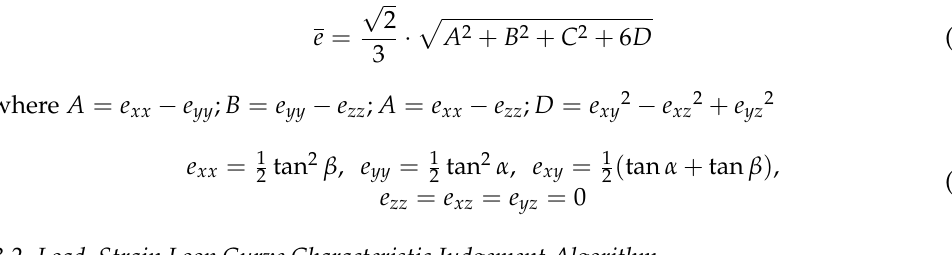
Figure 11. Load–strain distribution at different distances from the crack tip of Q&P 980 steel: ( a ) Measure points layout; ( b ) load–strain curve near the crack tip; ( c ) abstracted load–strain curve. The load–strain curve characteristic judgment algorithm was used to judge the de- formation region type according to the different characteristics of the load–strain curves of the pixel points in the crack tip region. There were 26 speckle images in each group of cyclic loads; hence, there were 26 observation points in the load–strain curve of each pixel within the crack tip strain field. The judgment process is shown in Figure 12. First, the yield strain value was taken as 0.002; if the proportion of the observed points in which the